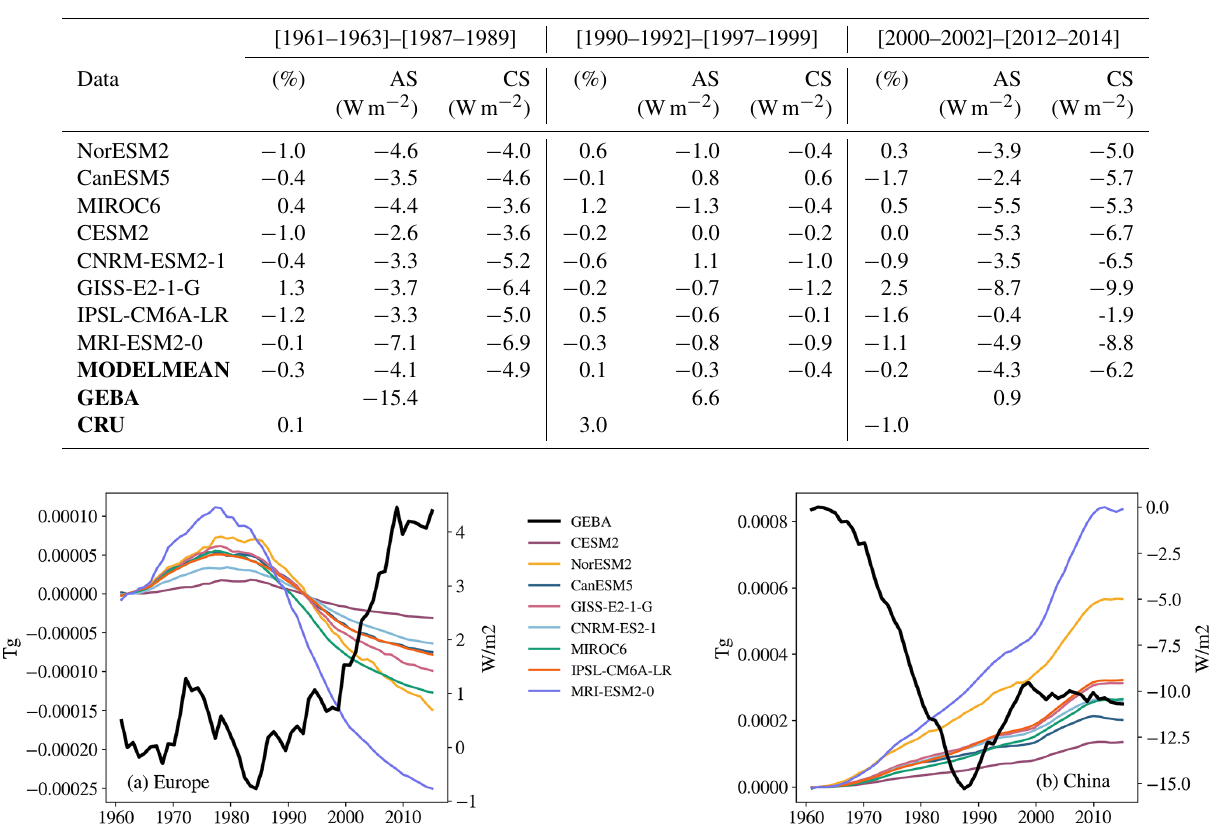
Table 2. Changes in Chinese cloud cover (%), all-sky SDSR AS (Wm − 2 ), and clear-sky SDSR CS (Wm − 2 ) between two 3-year means for three time periods. All model results are means made from three ensemble members of the historical simulation, co-located and extracted at Chinese GEBA station locations. Changes in cloud cover are from CRU gridded data and represent means co-located to Chinese GEBA stations.